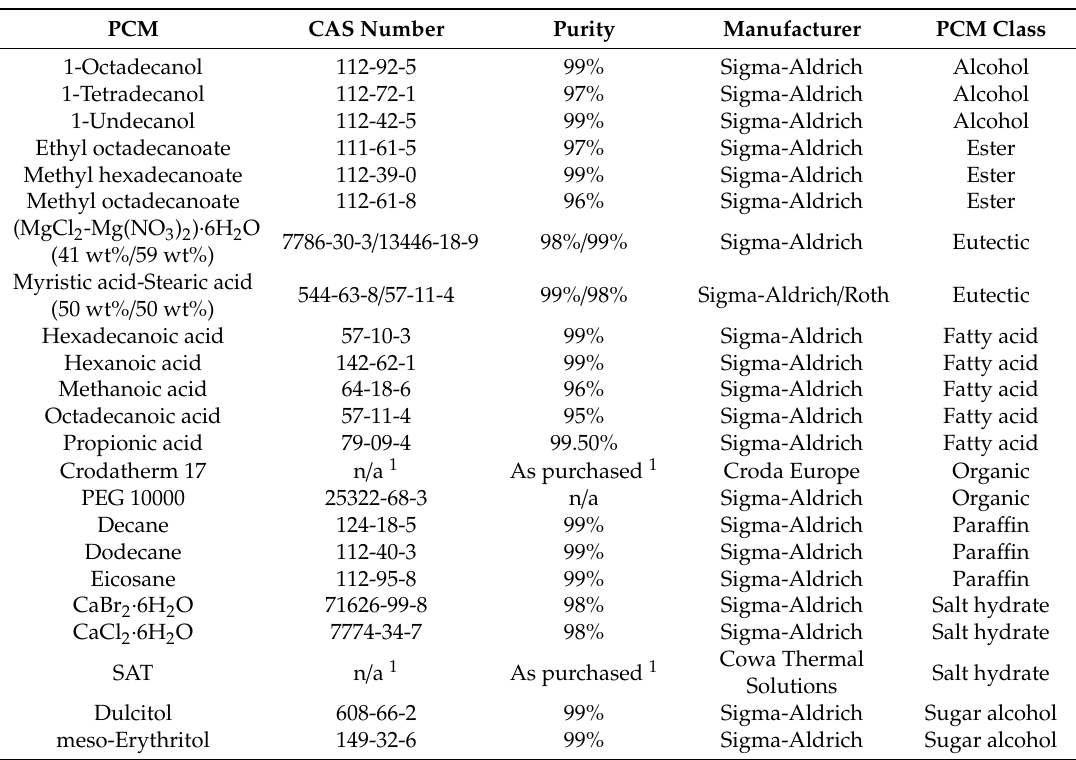
Table 1. Materials investigated within this study and the corresponding purity, manufacturer and